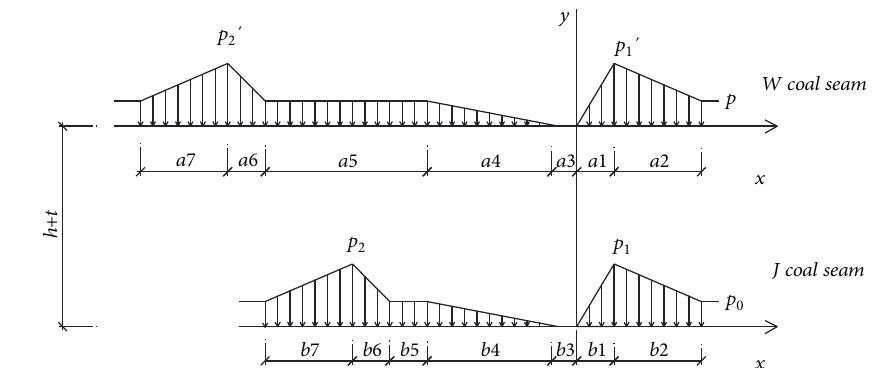
Figure 1: Mechanical model of underground structure.